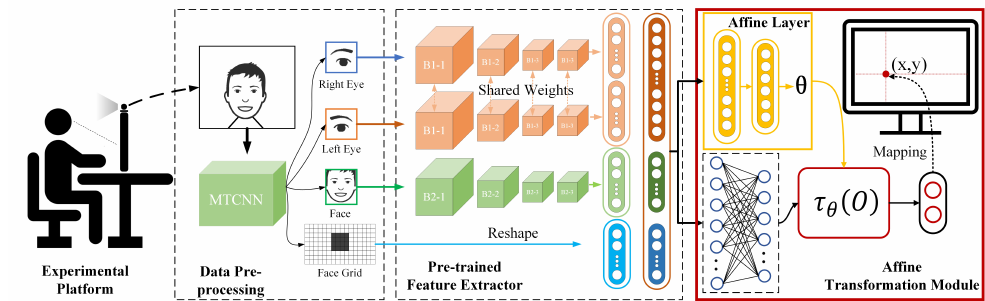
Figure 1. The architecture of the proposed eye tracking approach. The demonstration video can be found on the webpage